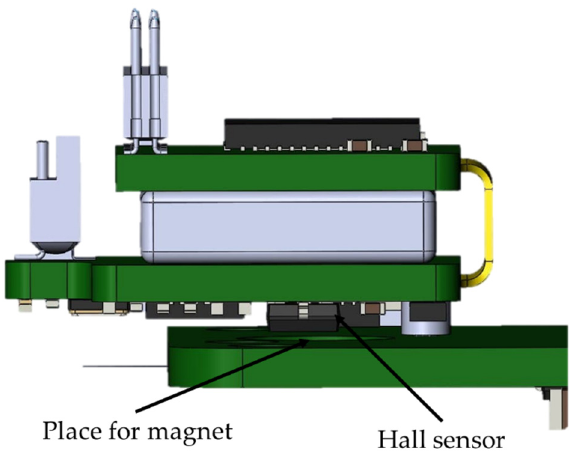
Figure 6. Charging the wireless module in the base station when a magnetic field appears in the Hall sensor.